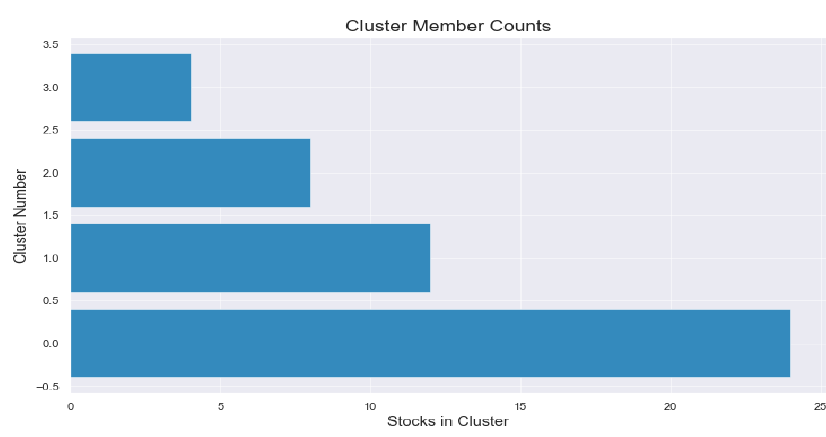
Figure 5. Number of shares in each cluster using the K-means method